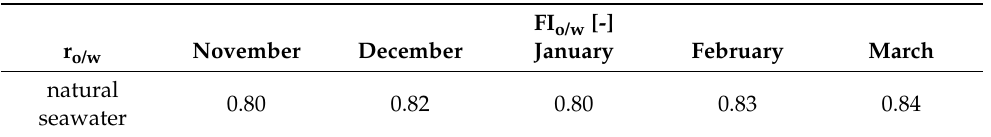
Table 9. FI o/w for natural (oil-free) seawater sampled in November, December, January, February and March in 2019/2020.